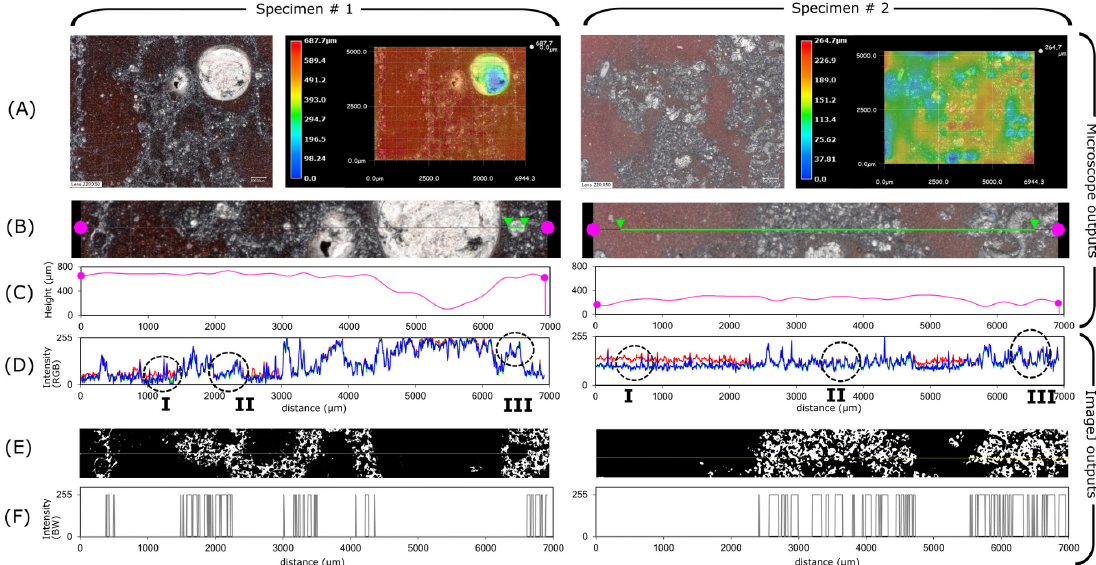
Figure 3. Preliminary observations by profile matching for specimens #1 and #2. ( A ) Original color contrasted optical images with their T-profile maps. ( B ) Selected lines for height and color profiles. ( C ) T-profiles (surface texture) corresponding to selected lines. ( D ) Corresponding intensity profiles in RGB space. ( E ) Preliminary binarization giving the porous char structure (solid in white, void in black). ( F ) Intensity profile of the binarized image through the selected